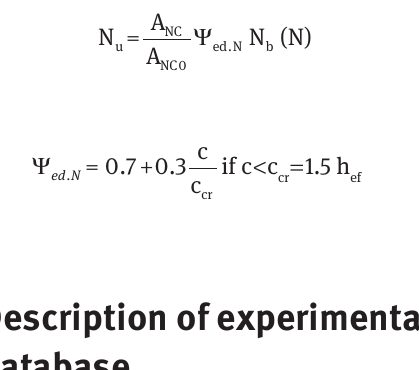
175 test data for group (quadruple) anchors and 142 test data for single anchors located close to a free edge. The frequency distribution of different parameters studied across the range of the 317 test results are presented in Tables 1 and 2 . Parameters for the group anchors data are = 8/12/16/24 mm), the embedment the anchor diameter (d an length (h from 4 d to 20 d), the anchor spacing (s from ef 0.33 h to 3 h ), the concrete height (h from 90 to 720 ef ef c mm), and the concrete strength (f from 22.4 to 63.7 MPa). c Variables for the single anchor data are the anchor dia- = 8/12/20 mm), the embedment length (h meter (d from an ef